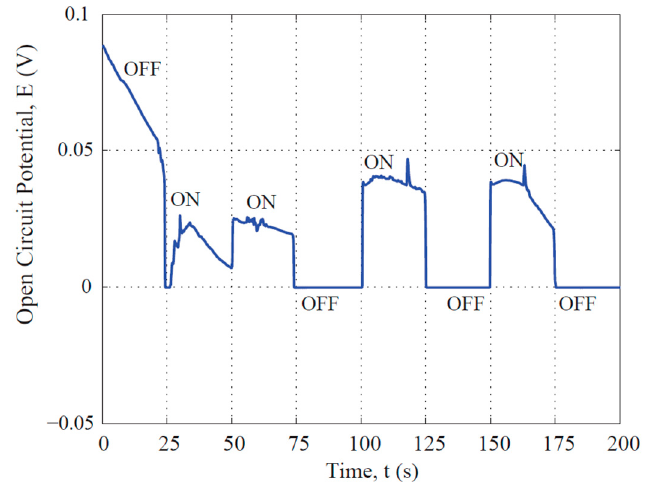
Figure 6. Photovoltaic response of the partially carbonized fiber coated with the titanium oxide nanoparticle coating to visible light showing the p-type semiconducting behavior.